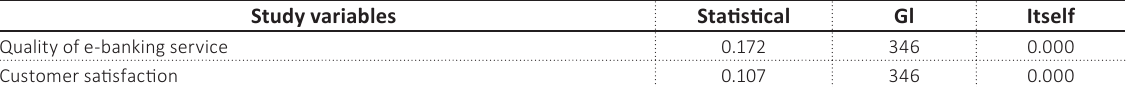
Table 4. Kolmogorov-Smirnov parametric statistics